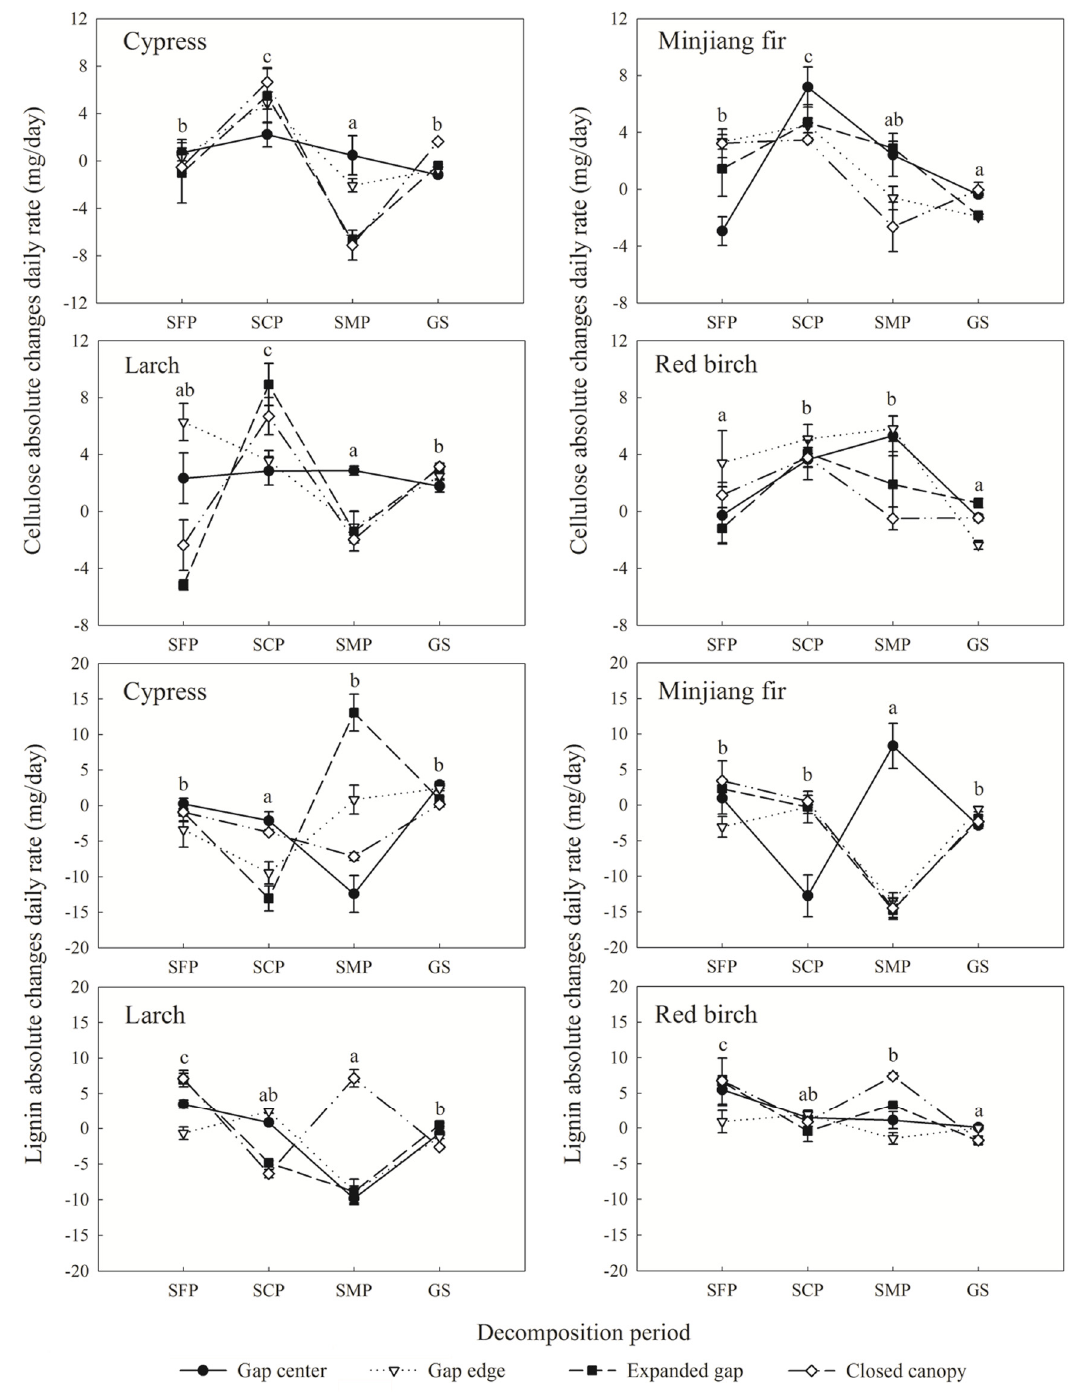
Figure 6. Cellulose and lignin absolute change daily rates (mg/day) for the four types of foliar litter (cypress, Minjiang fir, larch, red birch) in the four gap positions (gap center, gap edge, expanded gap, closed canopy) for each decomposition period (SFP, snow formation period; SCP, snow cover period; SMP, snow melt period; GS, growing season) over the first year of litter decomposition in an alpine Minjiang fir forest. Different lowercase letters indicate significant differences among periods, p < 0.05 (mean ± SE, n = 3).